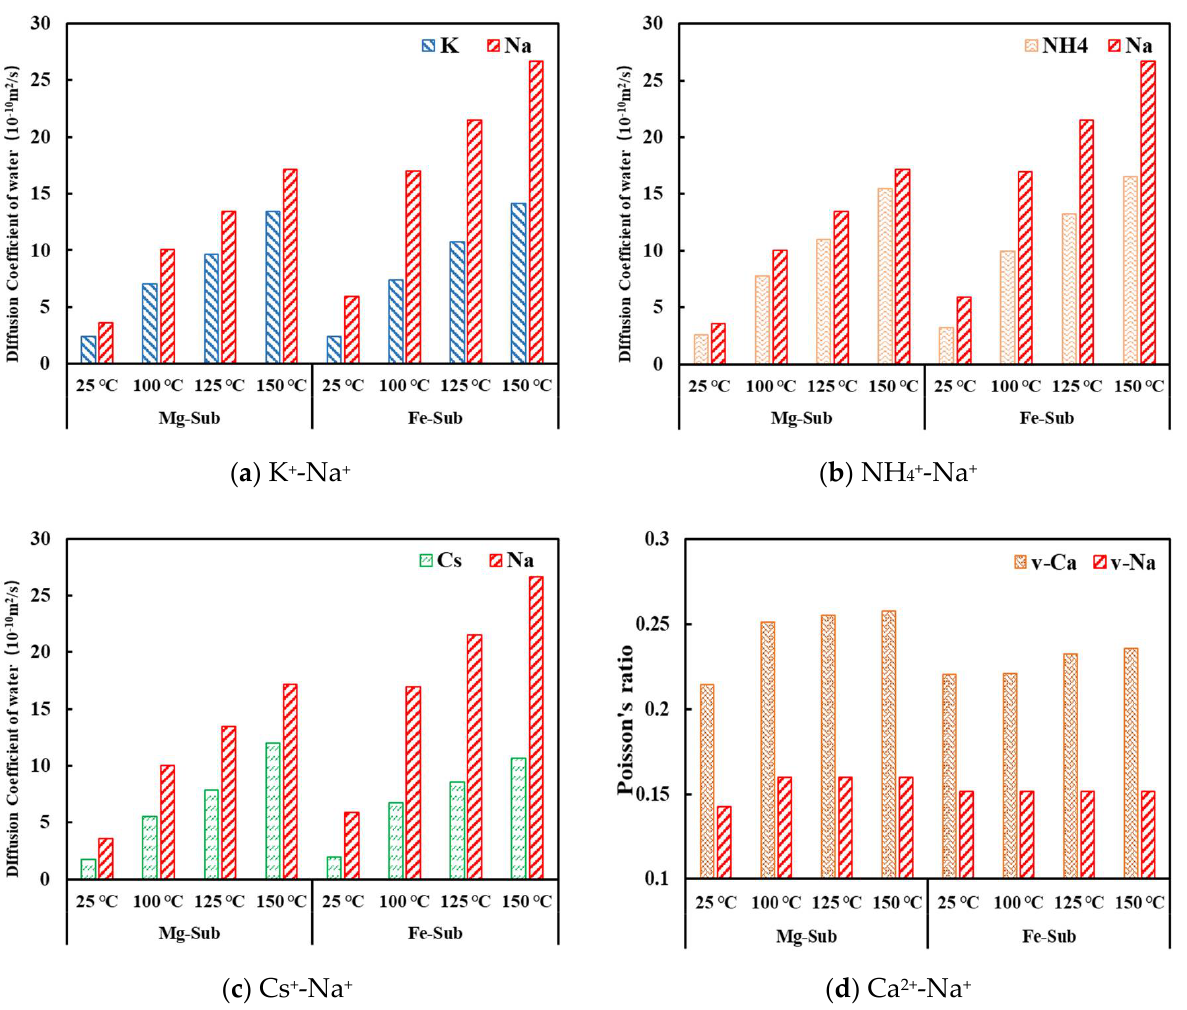
Figure 6. Diffusion coefficient of water of MMT system under different counterions and